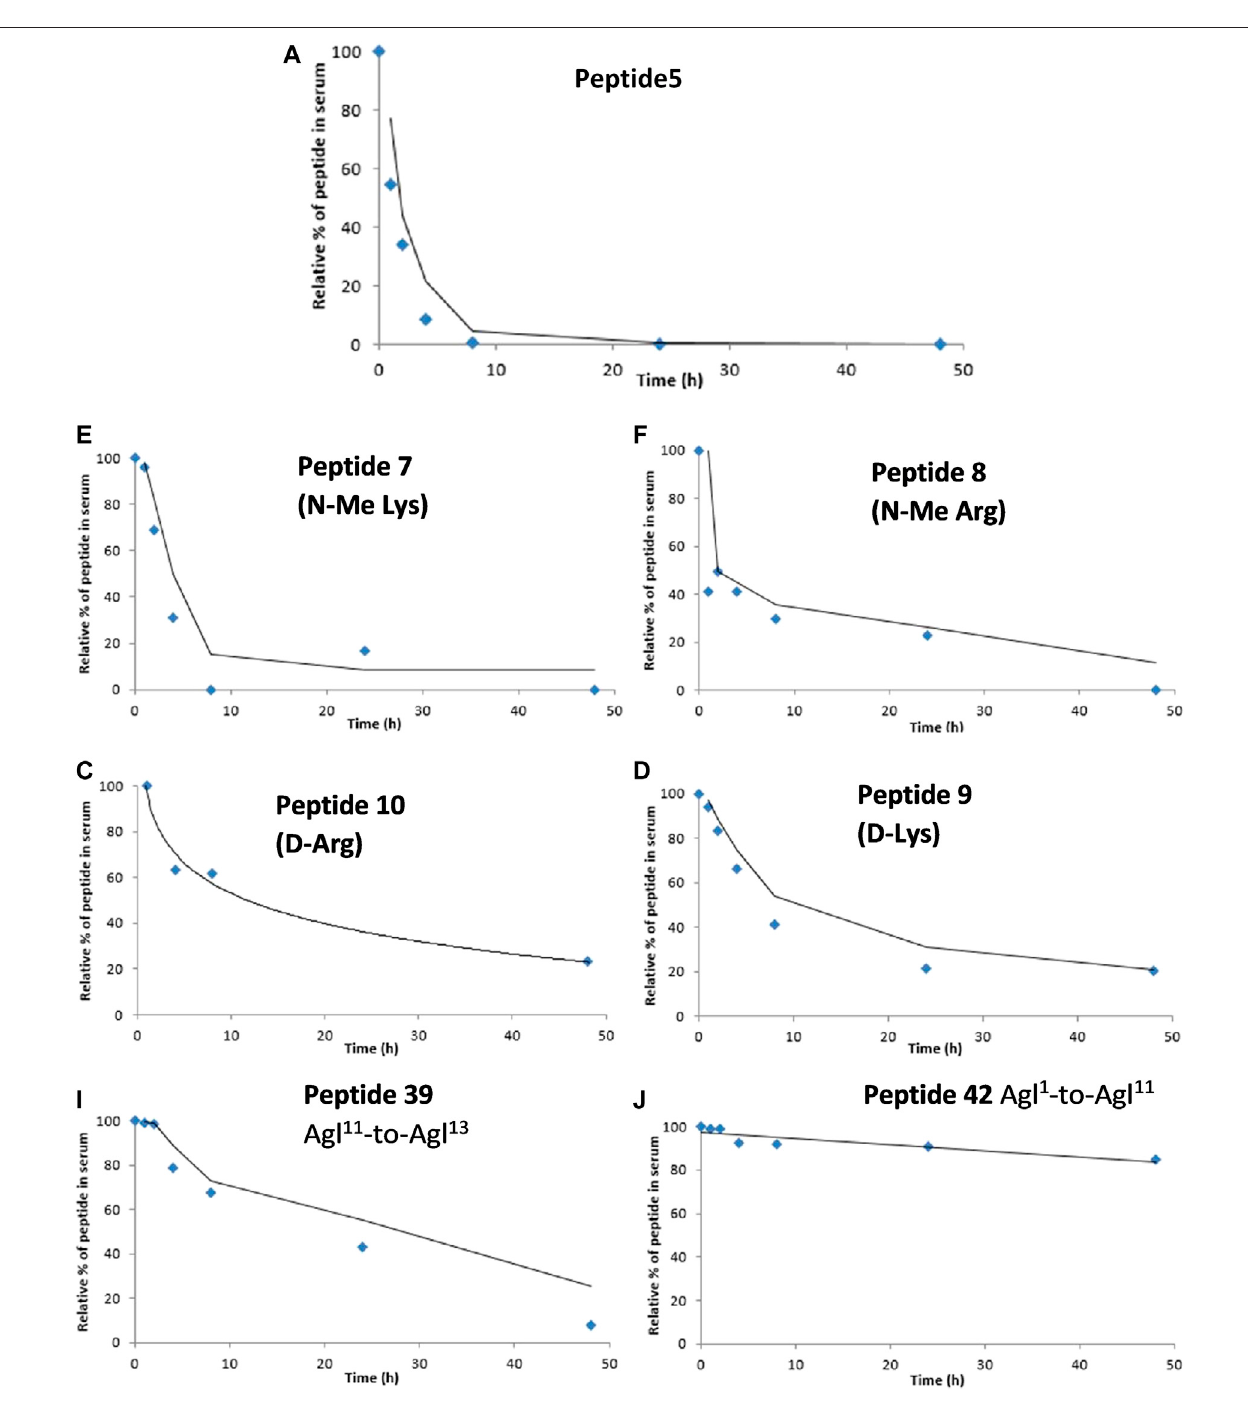
FIGURE 13 | Degradation studies of peptide5 and selected analogues in 25% human serum at 37 ° C via monitoring by HPLC at 210 nm.